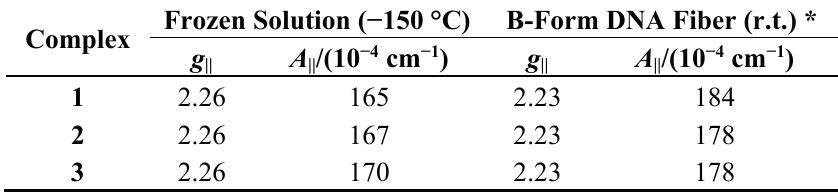
Table 1. The magnetic